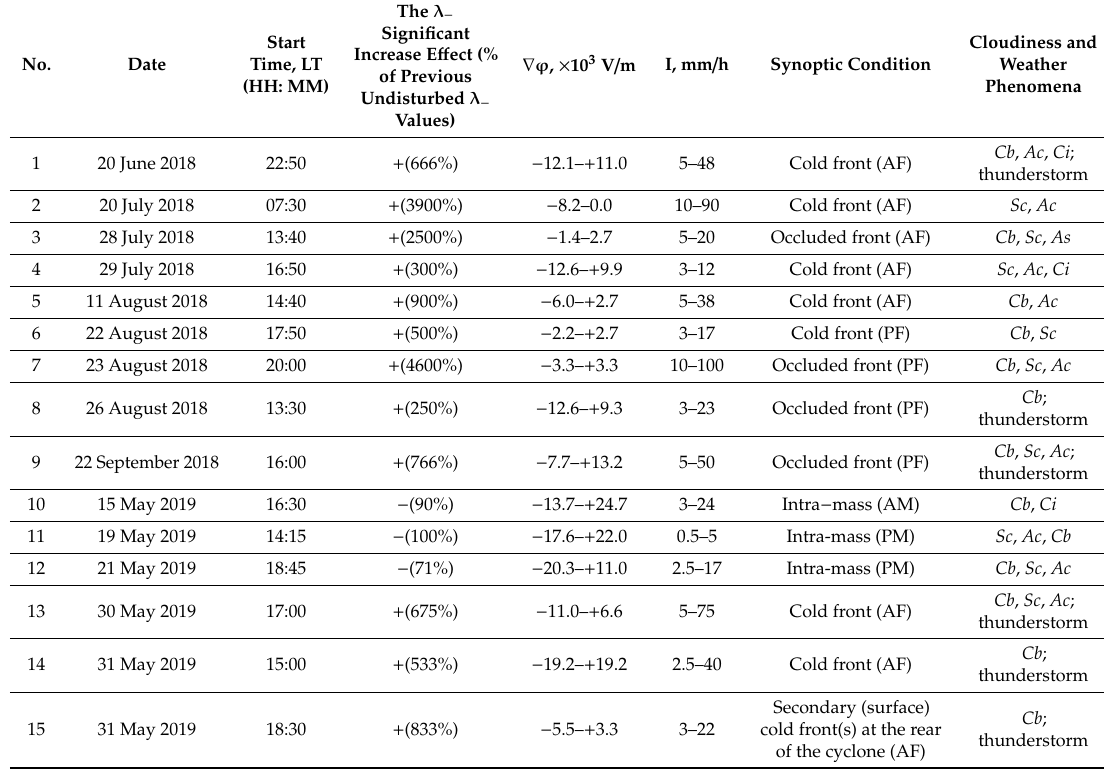
Table A1. Feedback of the negative electrical conductivity ( λ − ) of the atmospheric surface layer during rain